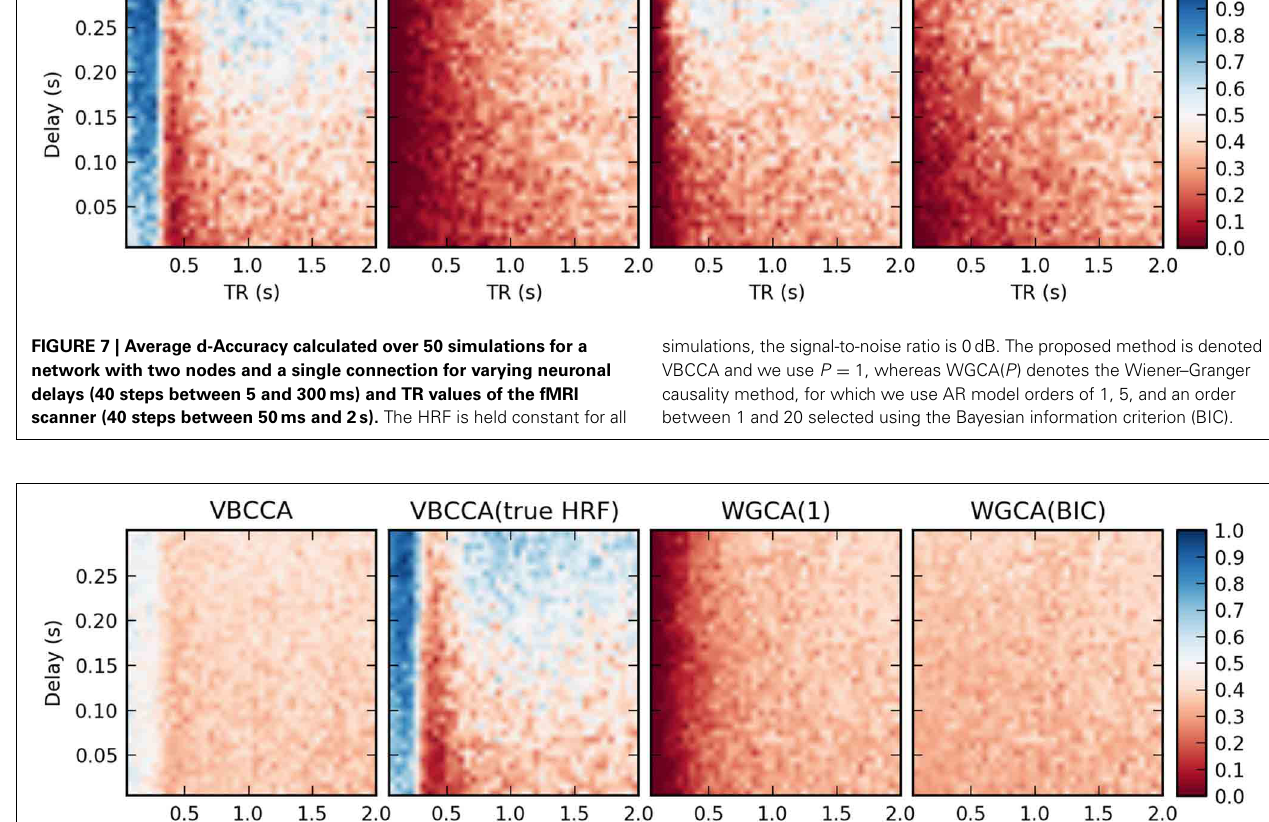
FIGURE 8 | Average d-Accuracy calculated over 50 simulations for a network with two nodes and a single connection for varying neuronal delays (40 steps between 5 and 300ms) and TR values of the fMRI scanner (40 steps between 50ms and 2s). Random HRFs are used with a time-to-peak uniformly distributed between 2.5 and 6.5s, as shown in Figure 6 , the signal-to-noise ratio is 0dB. The proposed method is